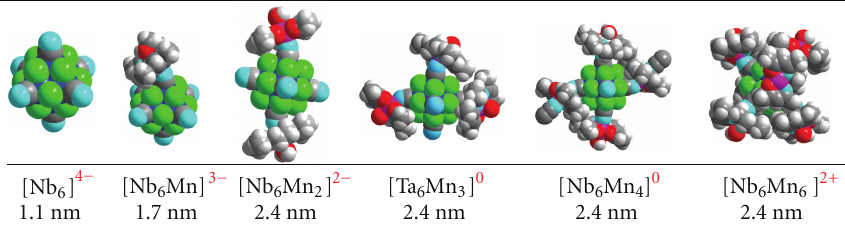
Table 1: The six supramolecular assemblies in which the cluster [Nb 6 Cl 12 (CN) 6 ] is linked to one, two, three, four, and six [Mn(III)( ACEN )]. [Nb 6 ] refers to the cluster [Nb 6 Cl 12 (CN) 6 ] 4 − and [Ta 6 ] refers to the cluster [Ta 6 Cl 12 (CN) 6 ] 3 − ; Mn = [Mn(III)( ACEN )] + . ( ACEN =